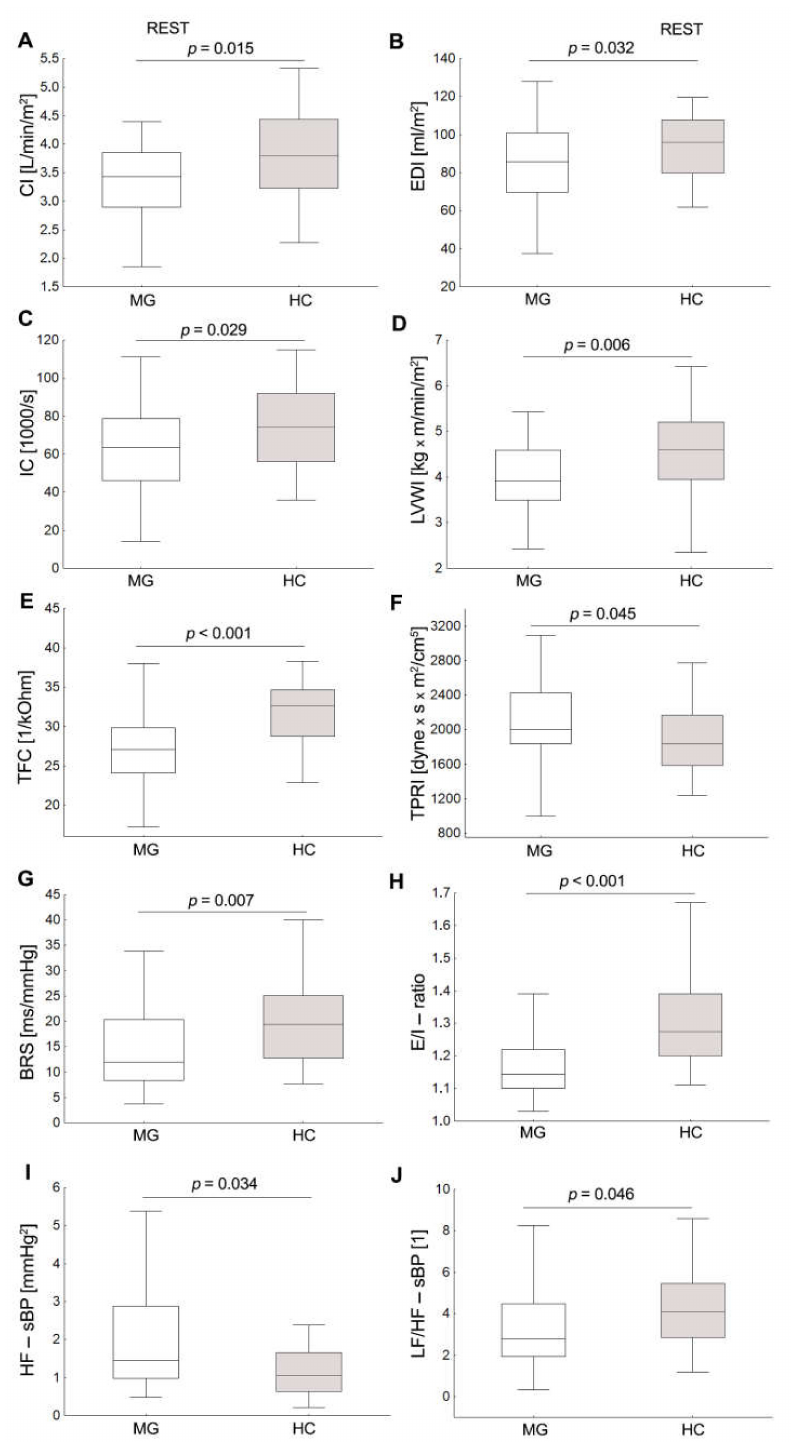
Figure 1. Scatter box plot showing the median, minimum and maximum values of CI, cardiac index ( A ); EDI, end-diastolic index ( B ); IC, index of contractility ( C ); LVWI, left ventricular work index ( D ); TFC, thoracic fluid content ( E ); TPRI, total peripheral resistance index ( F ); BRS, baroreflex sensitivity ( G ); E/I-ratio, expiration/inspiration ratio ( H ); ( I ) HF-sBP, high frequency of systolic blood pressure variability; LF/HF-sBP, the ratio between low and high band for systolic blood pressure variability ( J ) in MG group; respectively for compared to